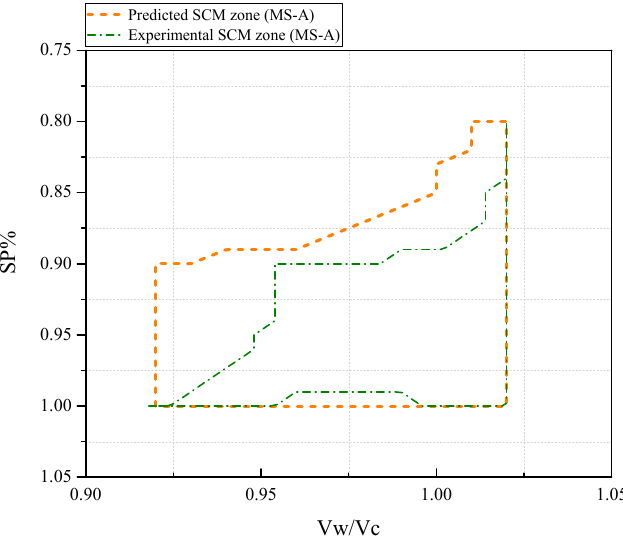
Figure 10. Comparison of predicted SCM zone and experimental SCM zone.